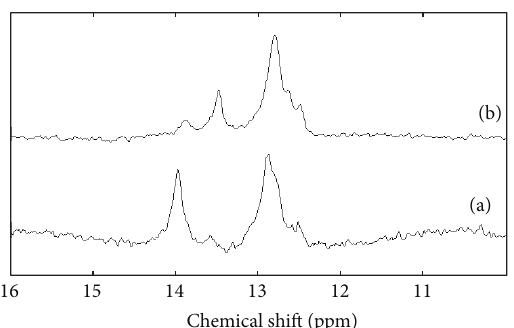
Figure 3: The 400 MHz proton imino spectra of 4A018 at (a) 278 and (b) 298